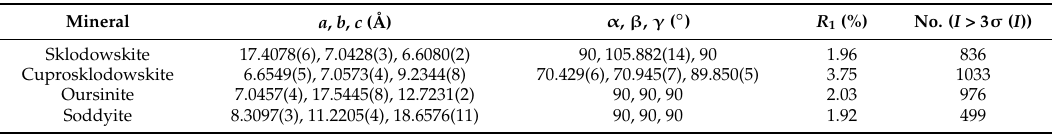
Table 2. Crystallographic data for uranyl silicate minerals studied by single-crystal X-ray diffraction